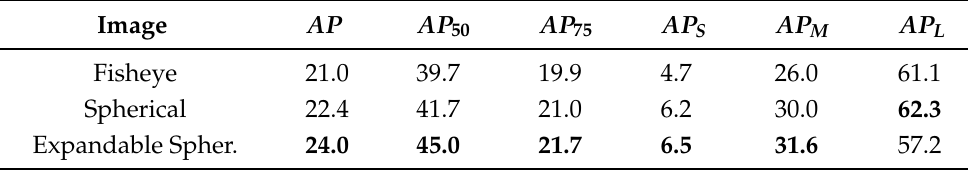
Table 7. Accuracy of different projections of LCat model on the Fisheye-CityScape.